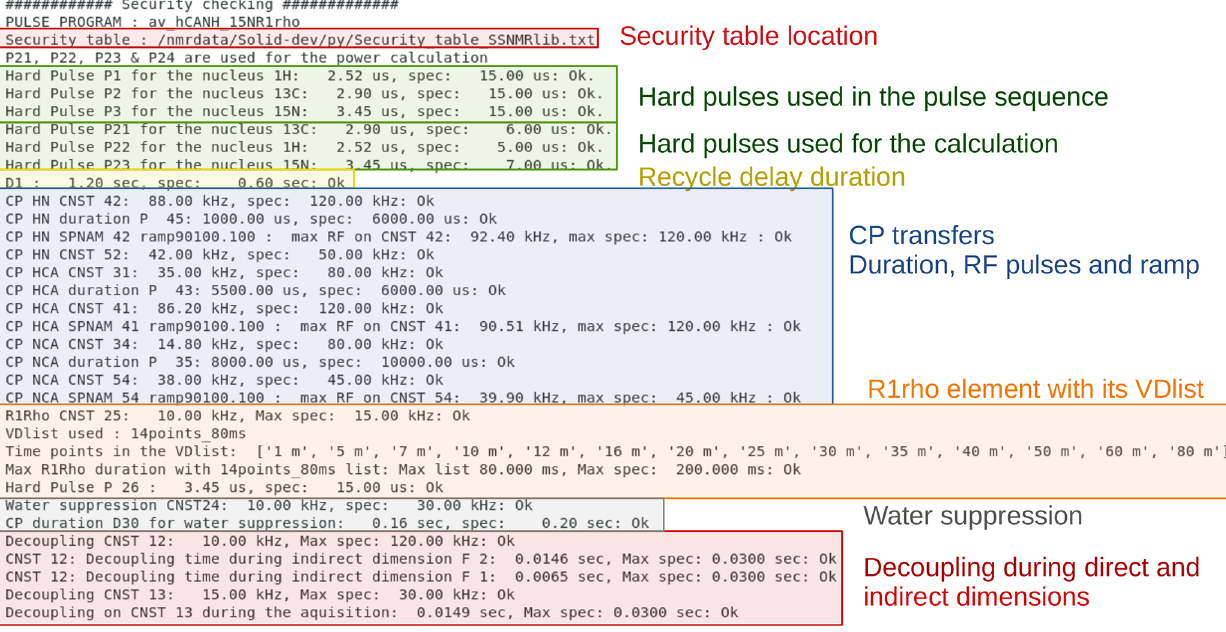
Figure 9. Example of security checks for the hCANH R1rho experiment. Shown is the output that ssNMRlib writes to the Linux console from which Topspin was started. All parameters used by the experiment are compared to values specified in a probe-specific table, and security warnings are issued in this console window as well as in a popup window in case a parameter exceeds the